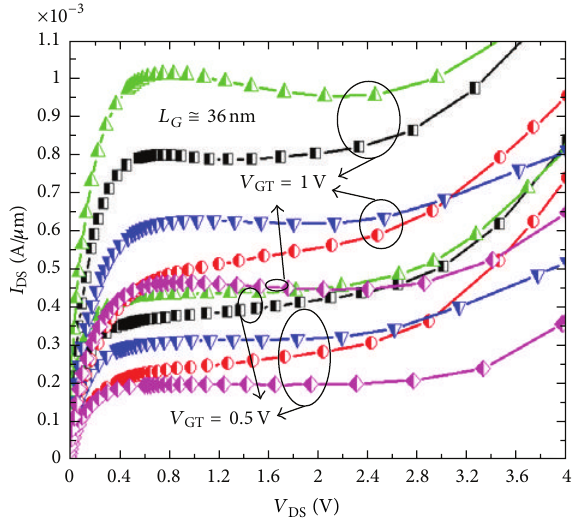
Figure 9: Comparison of bFDSOI and SOI MOSFETs 𝐼 characteristics with gate length 𝐿 𝐺 = 36 nm. The symbols are the same as in Figure